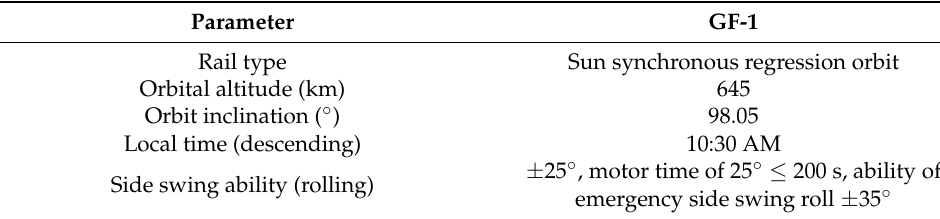
Table 1. GF-1 satellite orbit and attitude control parameters.